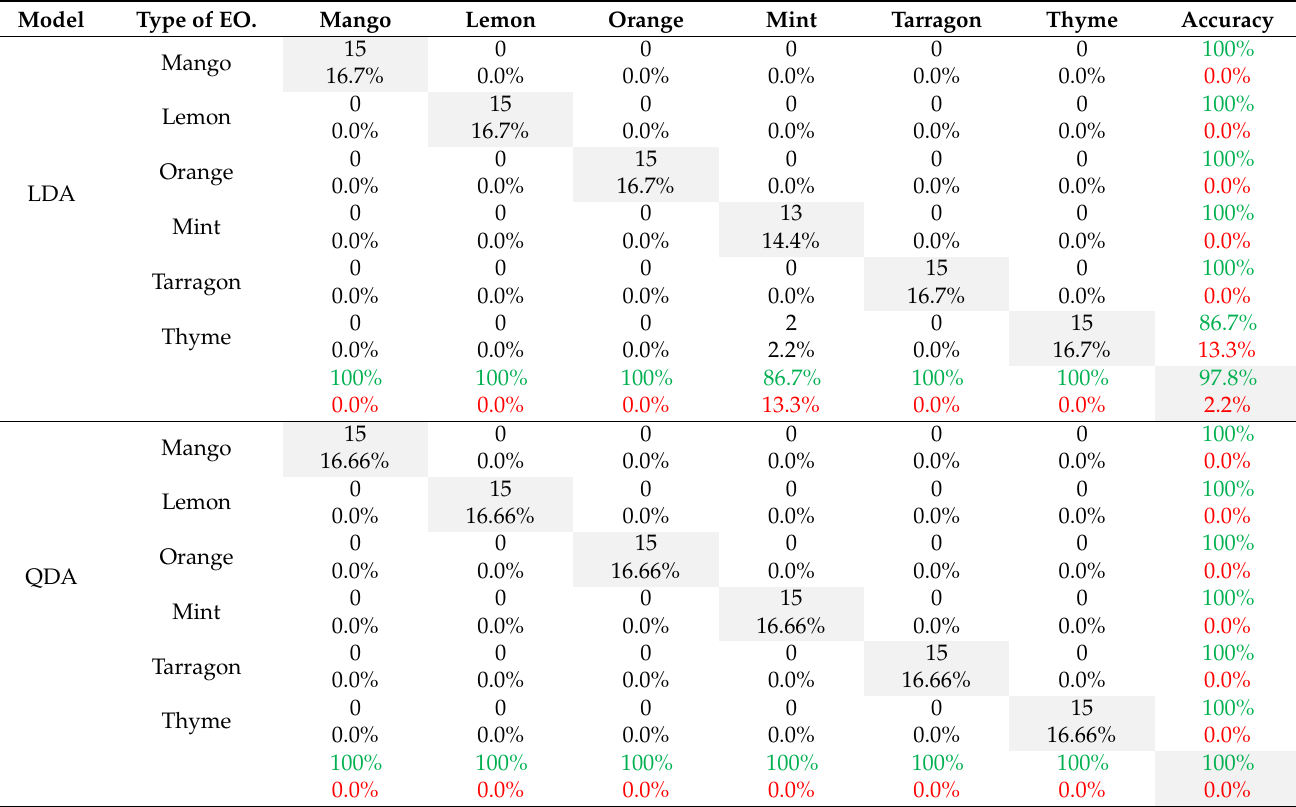
Table 3. Confusion matrix for six group classification using LDA and QDA methods. Model